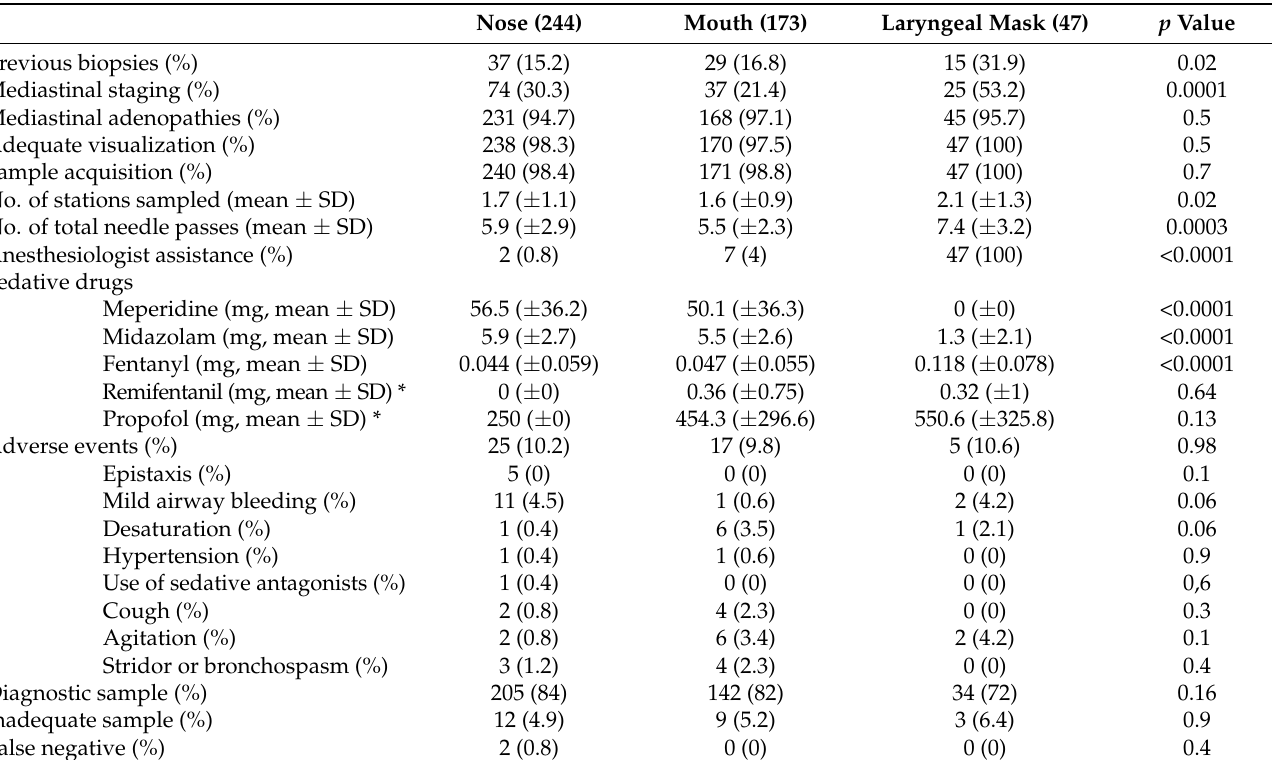
Table 4. Data regarding samples, procedural sedation, adverse events, and results of the three different access subgroups. * The mean, SD, and p values of propofol and remifentanil have been calculated, taking into account only cases with anesthesiologist assistance. SD, standard